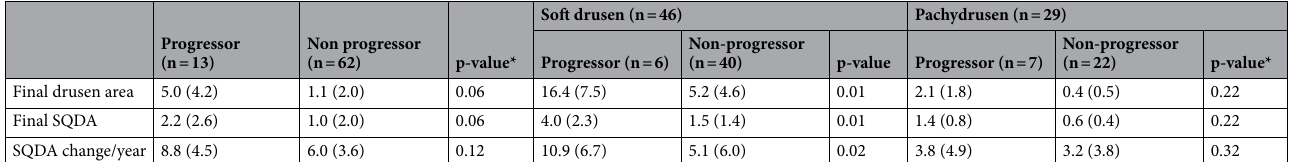
Table 4. Progression characteristics of incident exudative nAMD and stratified by drusen subtype. *Kruskal wallis test for comparison of non-parametric